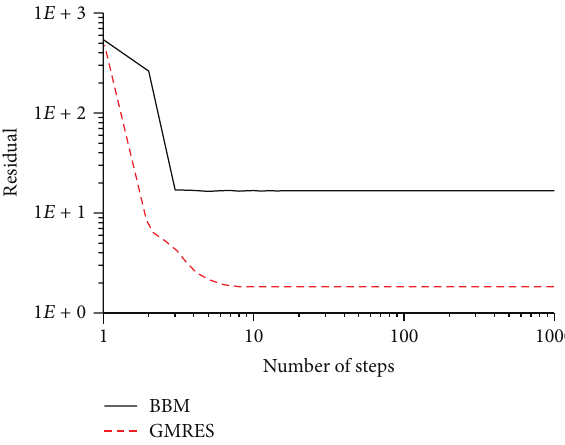
Figure 7: Example 5 showing residuals of GMRES and